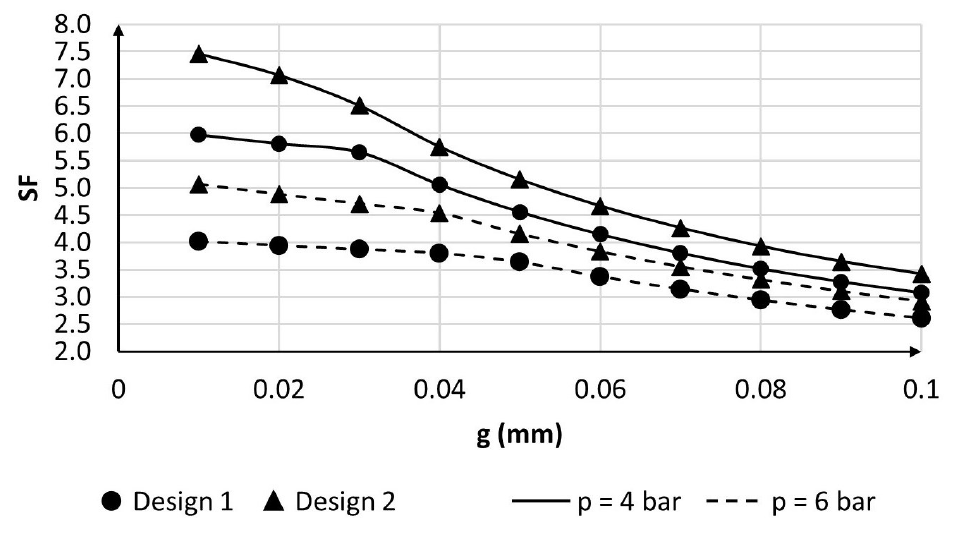
Figure 12. Safety factor as a function of the gap g for different designs and pressure values.